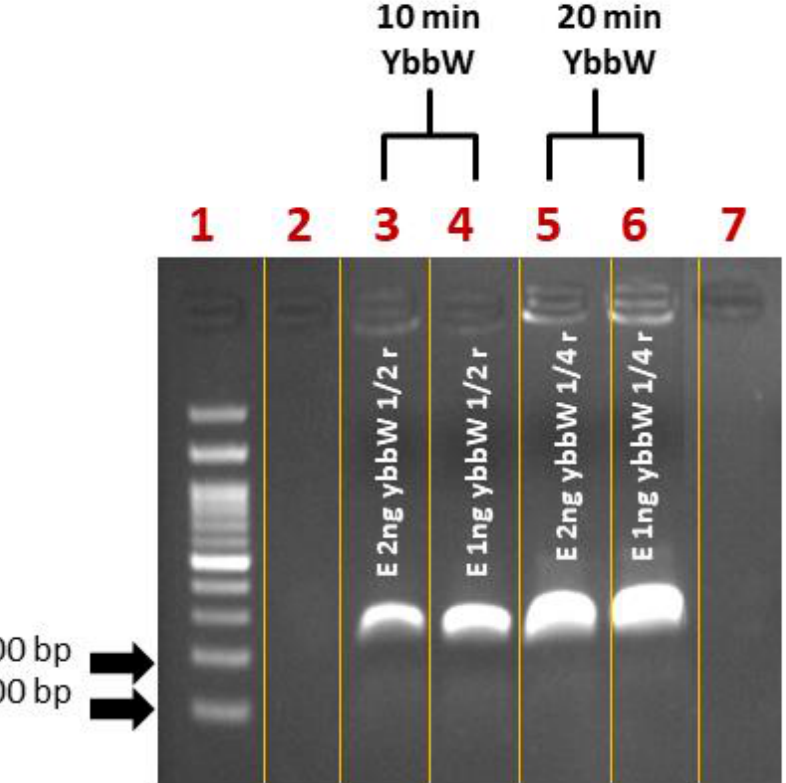
Figure 3. Agarose gel (2%) electrophoresis image of RPA reactions using ybbW primers and gDNA E. coli TOP10 (1–2 ng) as a template. The initial reaction was divided into different fractions before the amplification. The original TwistDx assay was performed for shorter time (Lane 3–4: 10 min and Lane 5–6: 20 min) and smaller sample volumes (Lane 3–4: 25 μL and Lane 5–6: 12.5 μL) than those